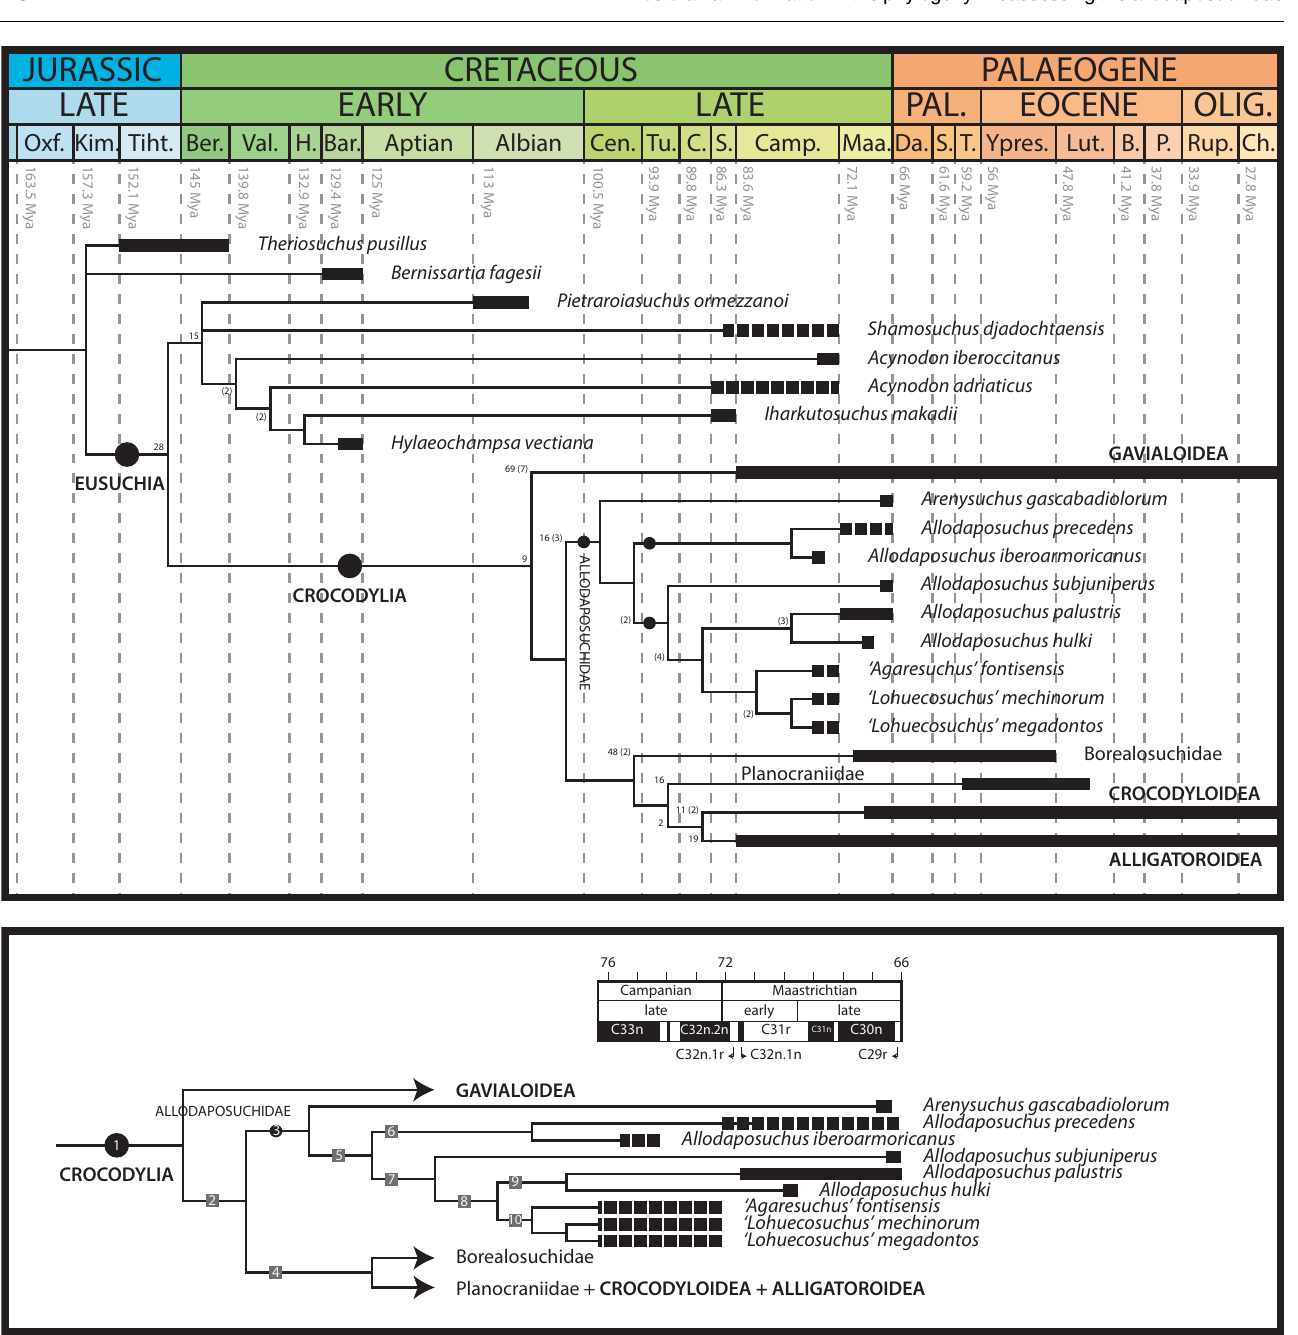
Fig 4. Strict consensus tree of the phylogenetic analysis with revised character codification and postcranial information (up), CI: 0.29, RI: 0.77; and detail of the family Allodaposuchidae showing common synapomorphies (down). Numbers in the consensus tree (up) indicate bootstrap frequencies for the main nodes, and Bremer support (over 2) in parentheses. Chronological ranges according to Fondevilla et al. [55]. Discontinuous bars represent approximate chronological ranges, and continuous bars reflect well-calibrated occurrences. Node 1 (Crocodylia): characters 71 1 , 74 0 , 118 1 , 121 1 , 131 0 , 158 1 ; node 2: